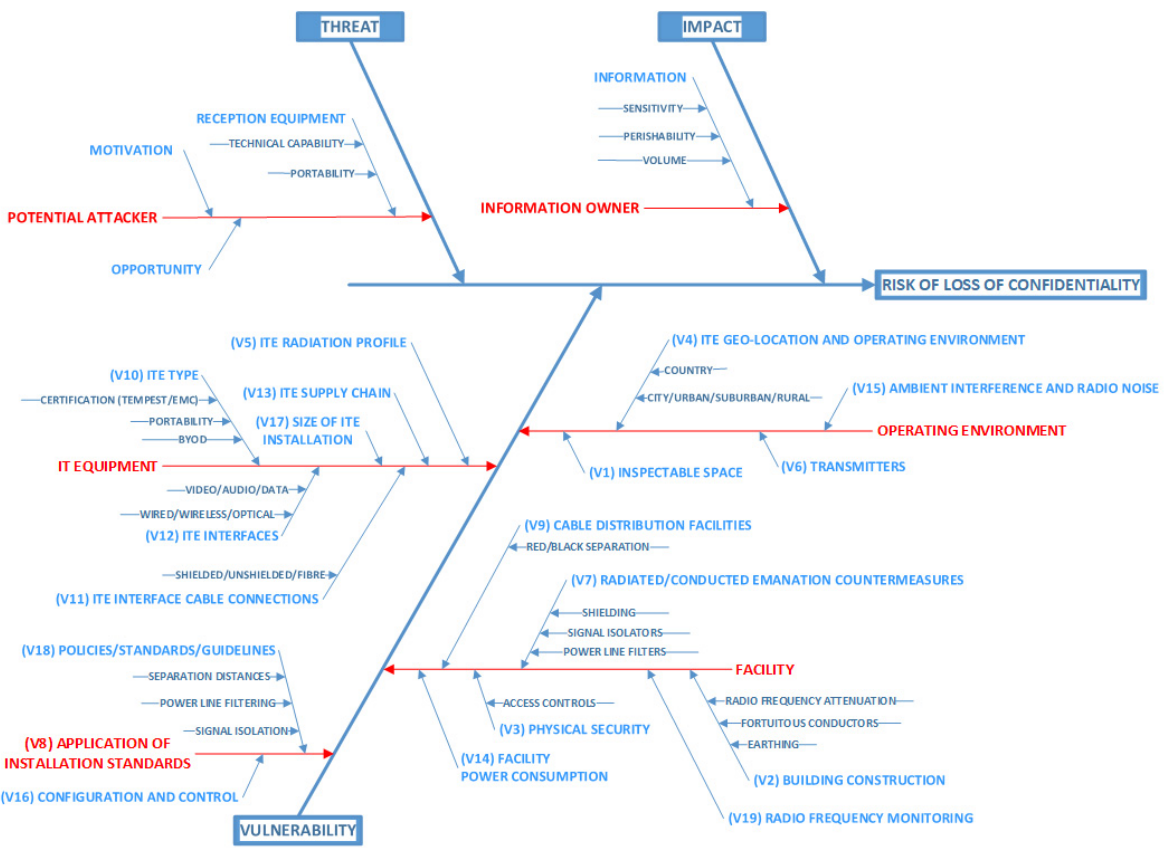
Figure 4. Categorization of the causal factors using the Ishikawa (fishbone) diagram .